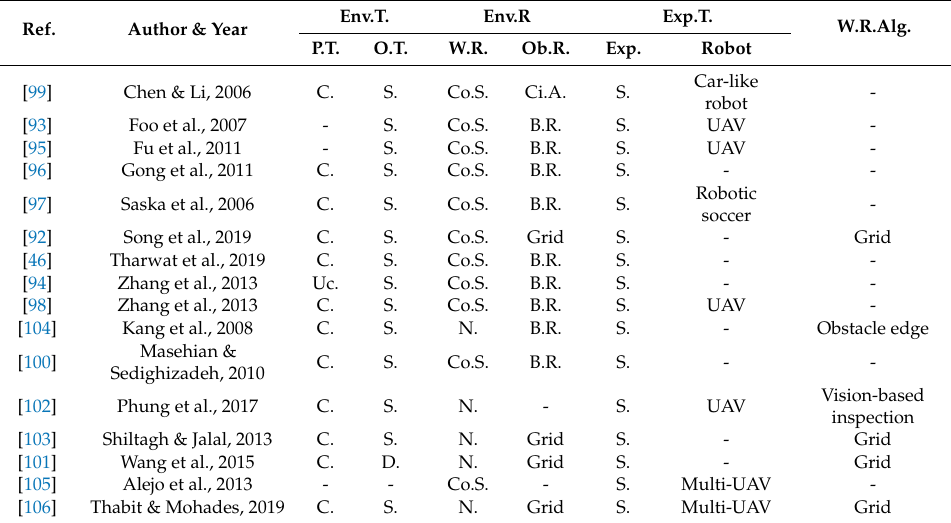
Table 6. Classification of the paper using the heuristic-based algorithm (PSO). Ref.